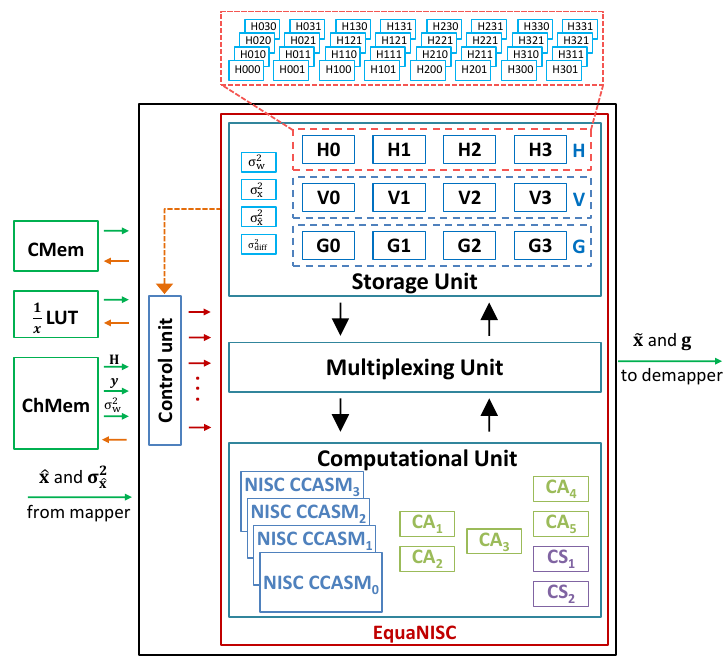
Figure 3. Proposed equalizer